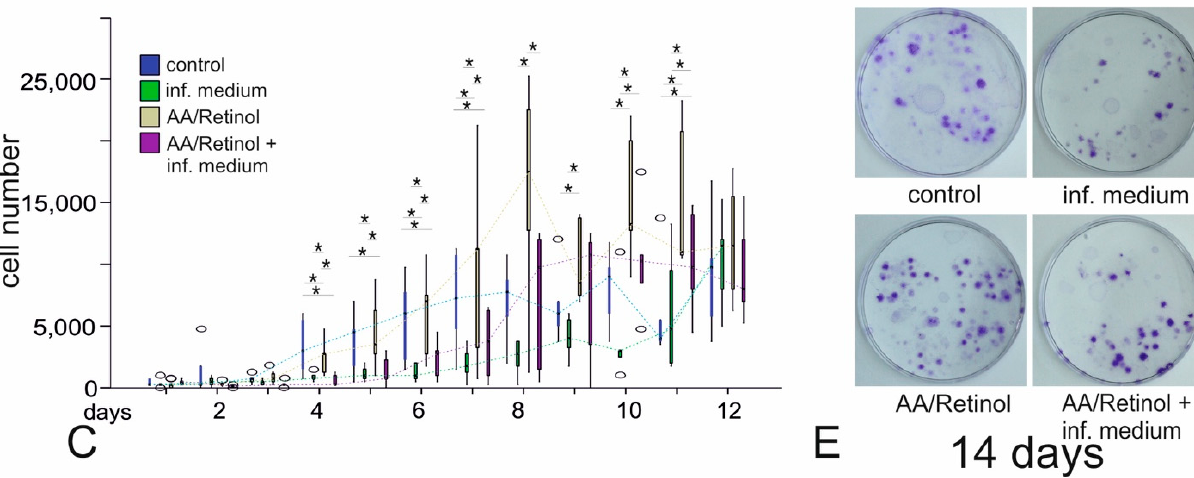
Figure 4. β -catenin expression, cellular proliferation and CFUs following AA/retinol and inflammatory stimulation of G-MSCs: ELISA examination of the phosphorylated (p β -catenin) and total (t β -catenin) intracellular β -catenin, following G-MSCs’ challenging by AA/retinol and inflammation (( A ) and ( B ); box and whisker plots with medians/quartiles). GMSCs’ cell proliferatory graph of the AA/retinol and inflammation stimulated groups over 14 days (( C ); box and whisker plots with medians/quartiles). CFUs assay/CFUs’ numbers following G-MSCs’ stimulation via ascorbic acid and inflammation (( D ); box and whisker plots with medians/quartiles). Significant differences denoted with asterisks ( n = 5, * p < 0.05; Friedman test). Representative CFUs of the four experimental groups ( E ). CFUs; colony-forming units, p β -catenin; phosphorylated β -catenin, t β -catenin; total (t β -catenin) intracellular β -catenin.